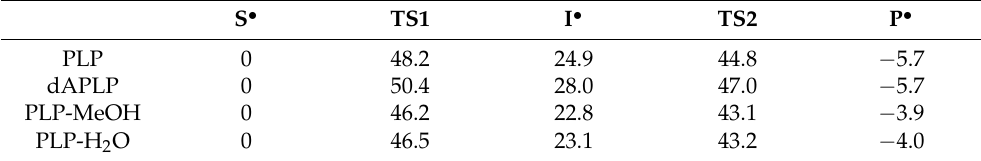
Figure 6. Relative energies of models of important radical intermediates in the reaction of 5,6-LAM. Table 2. Relative energies of important intermediate radicals and transition states in